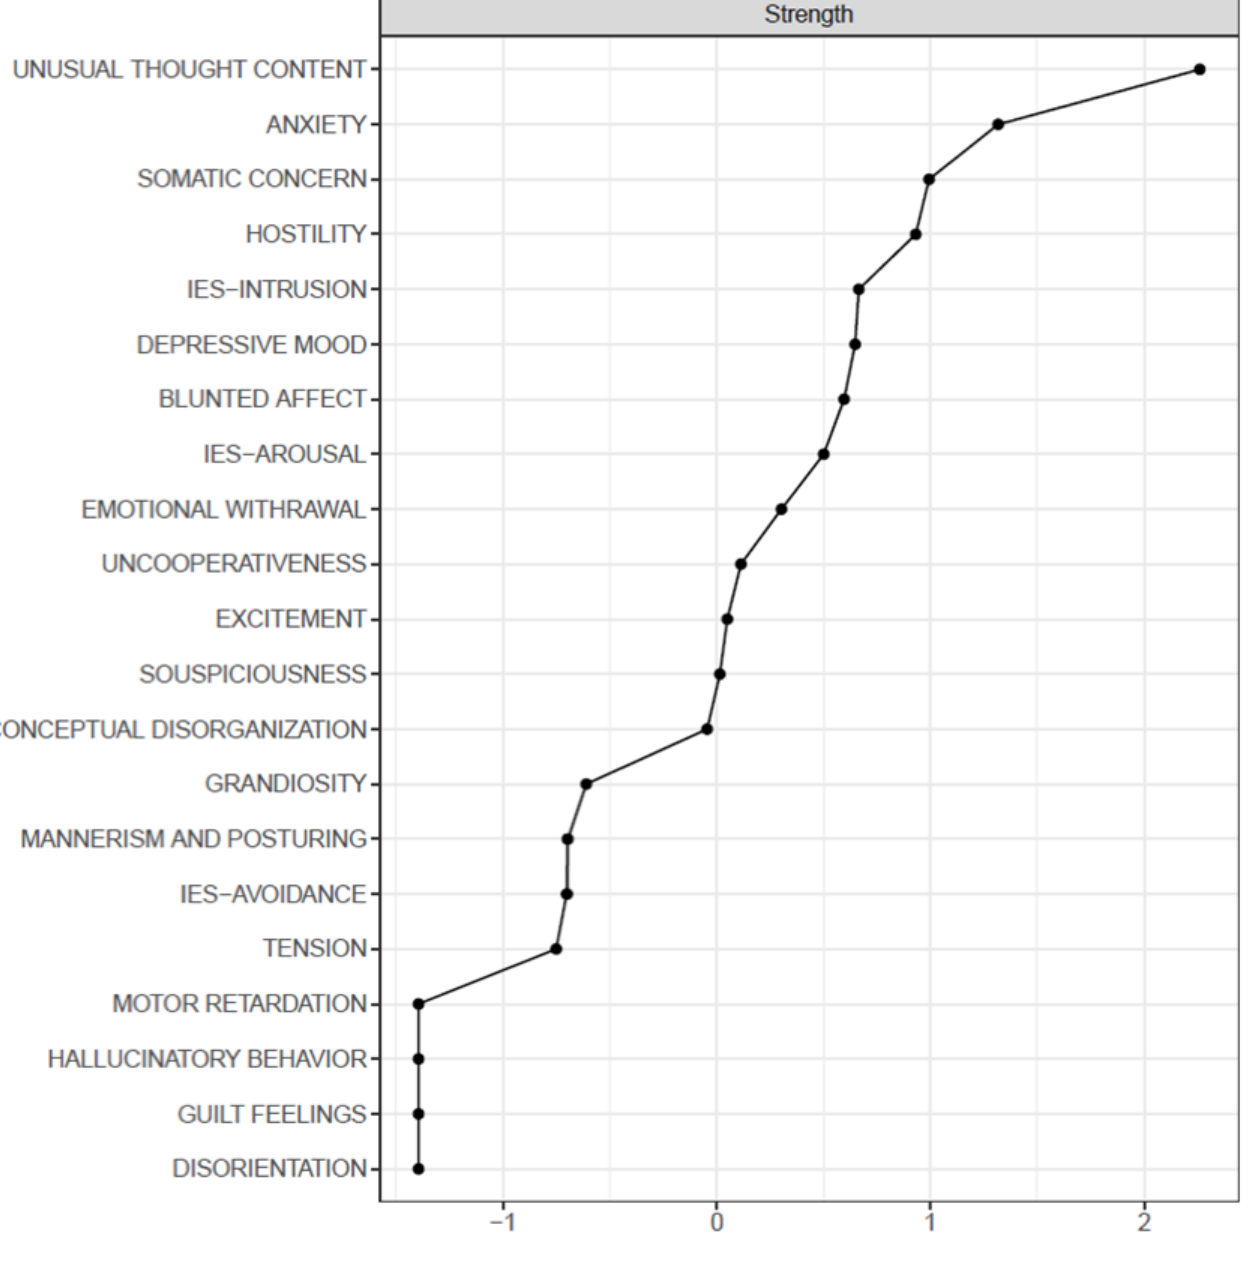
Figure 3. Centrality plot (strength) of the April sample.